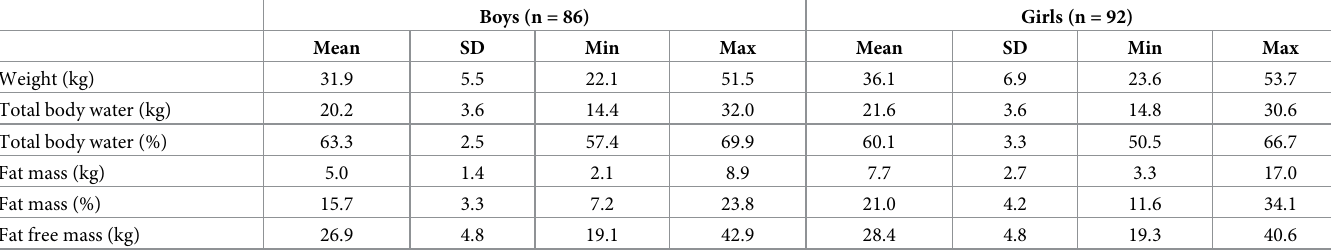
boys and girls were -2.05 and -1.30, and 51.2% and 22.8% were stunted. Mean BMI z-scores were -1.35 and -1.03. Body composition measured by deuterium dilution is shown in Table 2. Scatterplots illustrating associations of anthropometric and bioimpedance measurements with TBW (kg) and TBW (%) measured by deuterium dilution are shown in S1 and S2 Figs. Table 2. Body composition measured by deuterium